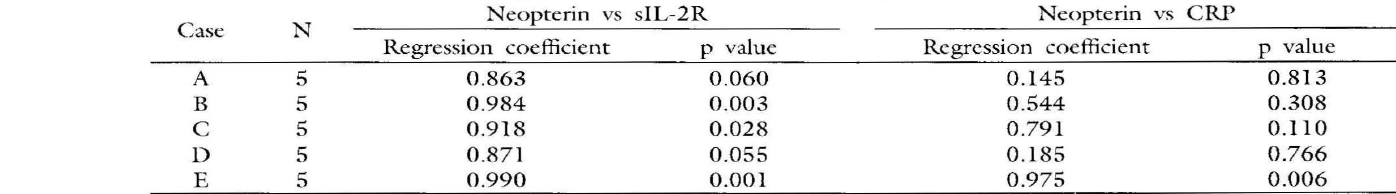
Table 2. Correlation between plasma levels of neopterin, so luble interleukin-2 receptors (sIL-2R) and C-reactive pro tein (CRP) in patients with